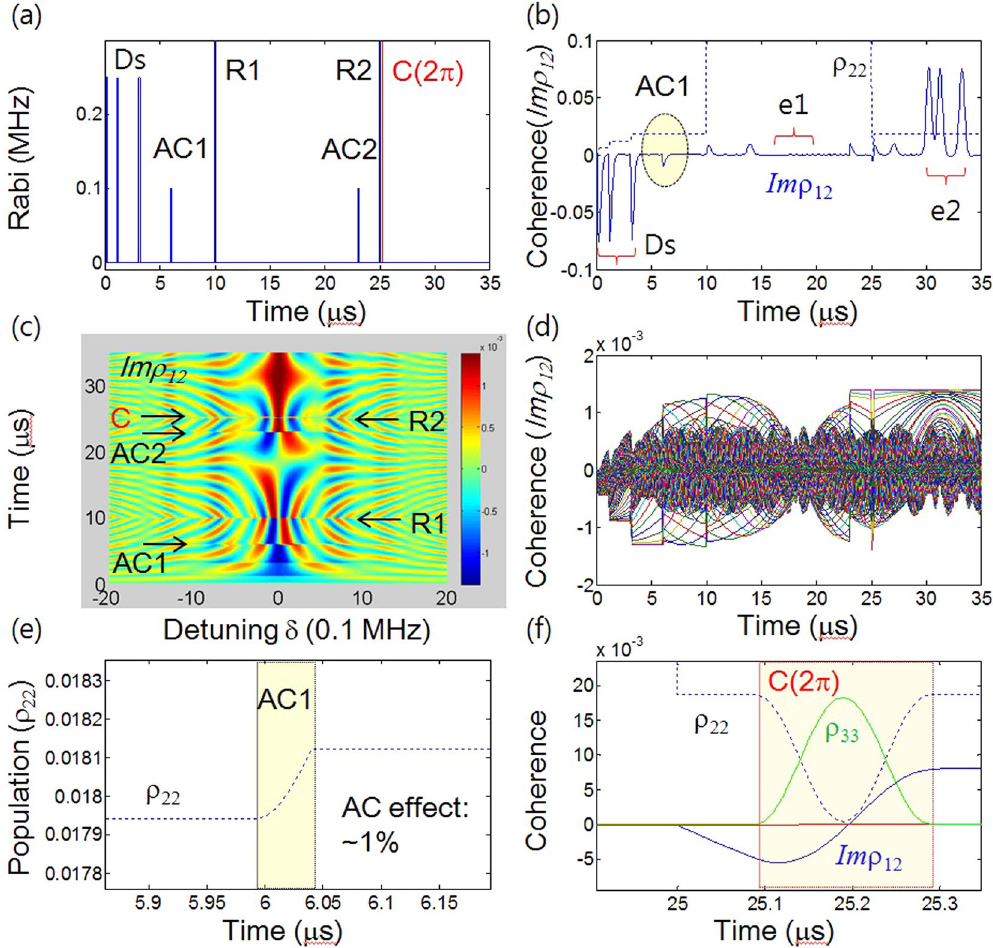
Figure 5. Controlled ac Stark echoes (CASE) in doubly rephased photon echoes for multiple weak data Ds. Three consecutive D pulses at 0.1,1.1, and 3.1 μ s with the same area of π /20. Ω AC1 = Ω AC2 = 0.1 MHz. Φ = Φ = π /2. Δ = Δ = 5 MHz. Ω = Ω = 50 MHz. Ω = 5 MHz. All decay rates are zero. Optical AC1 AC2 AC1 AC2 R1 R2 C inhomogeneous broadening is 1.7 MHz. ( a ) Pulse sequence. ( b ) Numerical results of ( a ). ( c ) 3D figure of ( b ). ( d ) Individual coherence evolution of ( b ). ( e ) ac Stark pulse-induced population change on ρ 22 . ( f ) Control Rabi flopping induced coherence